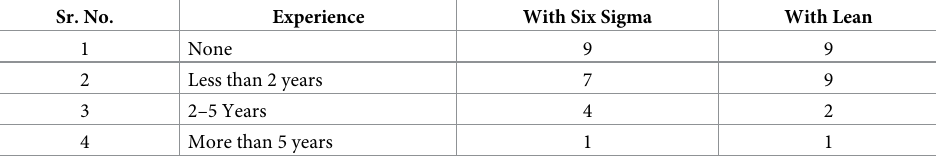
Table 5. Frequency of respondents having experience with Lean & Six Sigma. Sr.